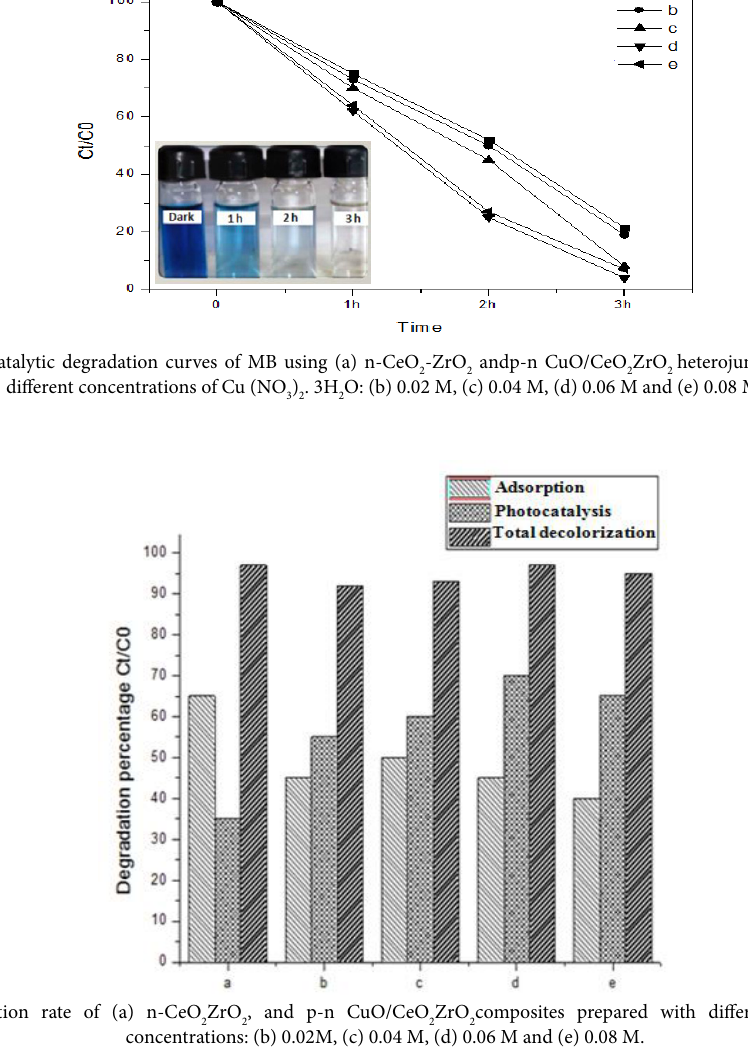
ZrO , and p-n CuO/CeO 2 2 concentrations: (b) 0.02M, (c) 0.04 M, (d) 0.06 M and (e) 0.08